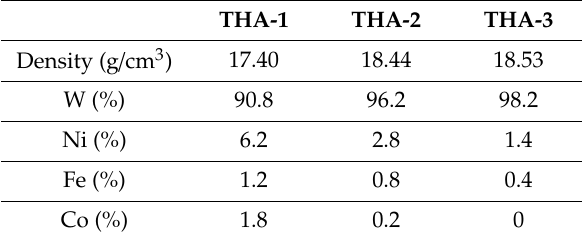
Table 1. Composition of materials used for research on tungsten heavy alloys